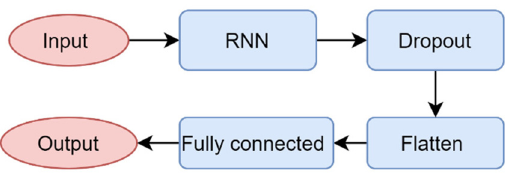
Figure 4: The RNN structure.